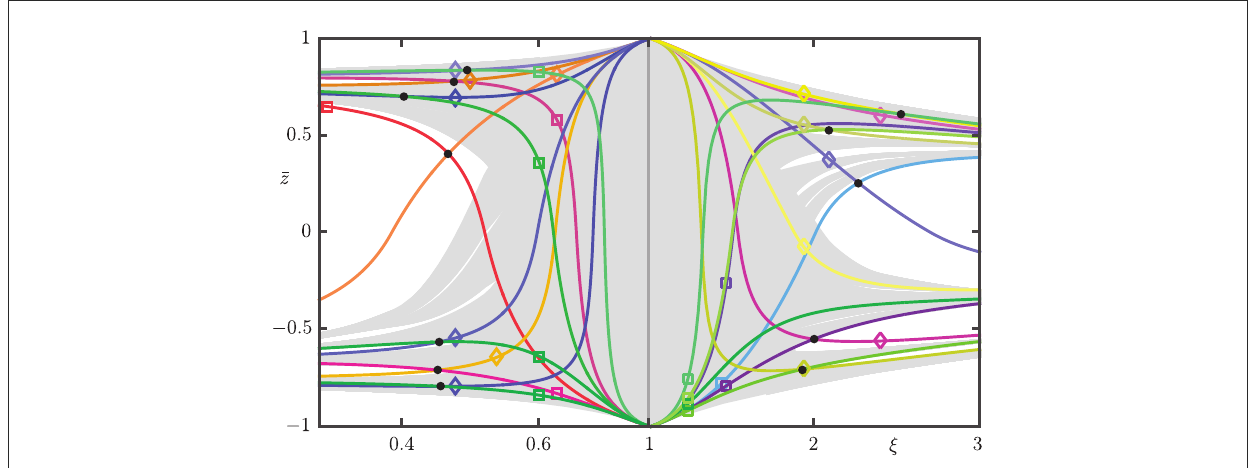
FIGURE14 Curves 3 ¯ z ( ξ ) and (cid:3) ¯ z ( ξ ) of opposing sub-boxes for B ± and D ± , D ±∓ and B ±∓ , and B ±∓± and D ±∓± , shown with W u ( p ± ) ∩ 6 and W s ( p ± ) ∩ 6 as in Figures 12,